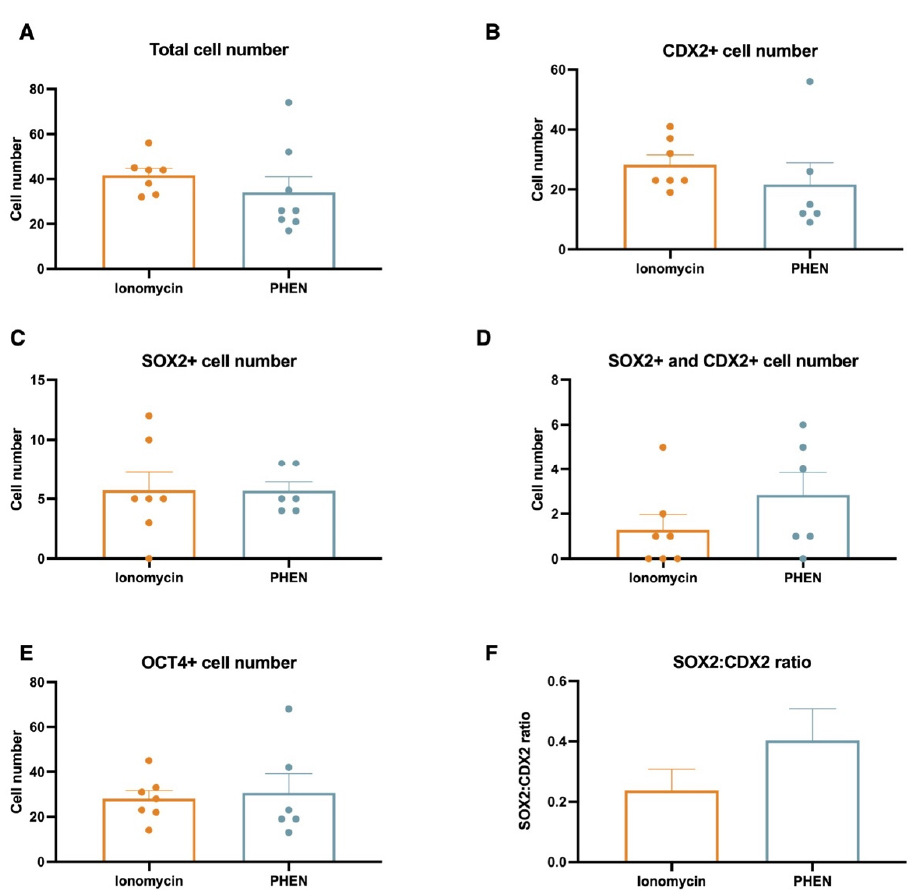
Figure 4. Analysis of cell number and expression of transcription factors of porcine blastocyst from different experimental groups. Blastocysts from three biological replicates were analyzed; 6 to 8 embryos/group; p < 0.05, Mann-Whitney test. No statistical differences were found among groups. PHEN, 1,10-phenanthroline.